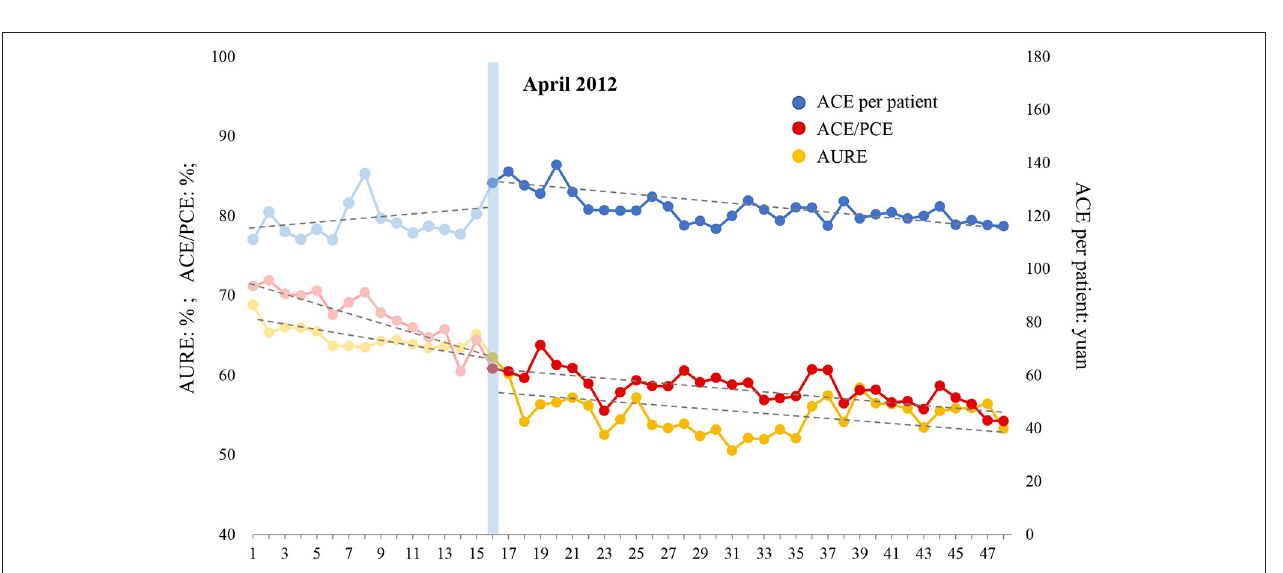
FIGURE 4 | Effect of intensified CSRA policy on three indicators representing antibiotic use of emergency patient. AURE, antibiotic use rate of emergency patients; ACE, antibiotic cost of emergency patients; PCE, prescription cost of emergency